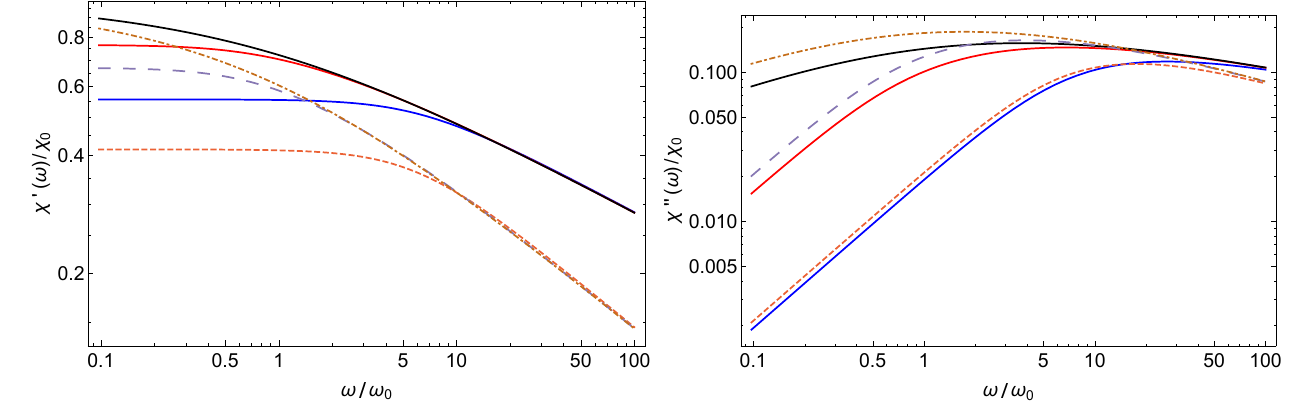
Figure 11. Behaviour of the complex susceptibility (log–log plot) for Havriliak–Negami relaxation with resetting. The black and dot–dashed lines correspond to Havriliak–Negami relaxation without resetting for ν = 0.5 and ν = 0.75, respectively. The solid red line and blue dashed line correspond to the r -parameter value of 0.5 for ν = 0.5 and ν = 0.75, respectively. The solid blue line and orange dashed lines correspond to the r -parameter value of 5 for ν = 0.5 and ν = 0.75, respectively. The parameter α is taken to be 0.5 for both cases. Left panel : real part. Right panel : imaginary part (dielectric